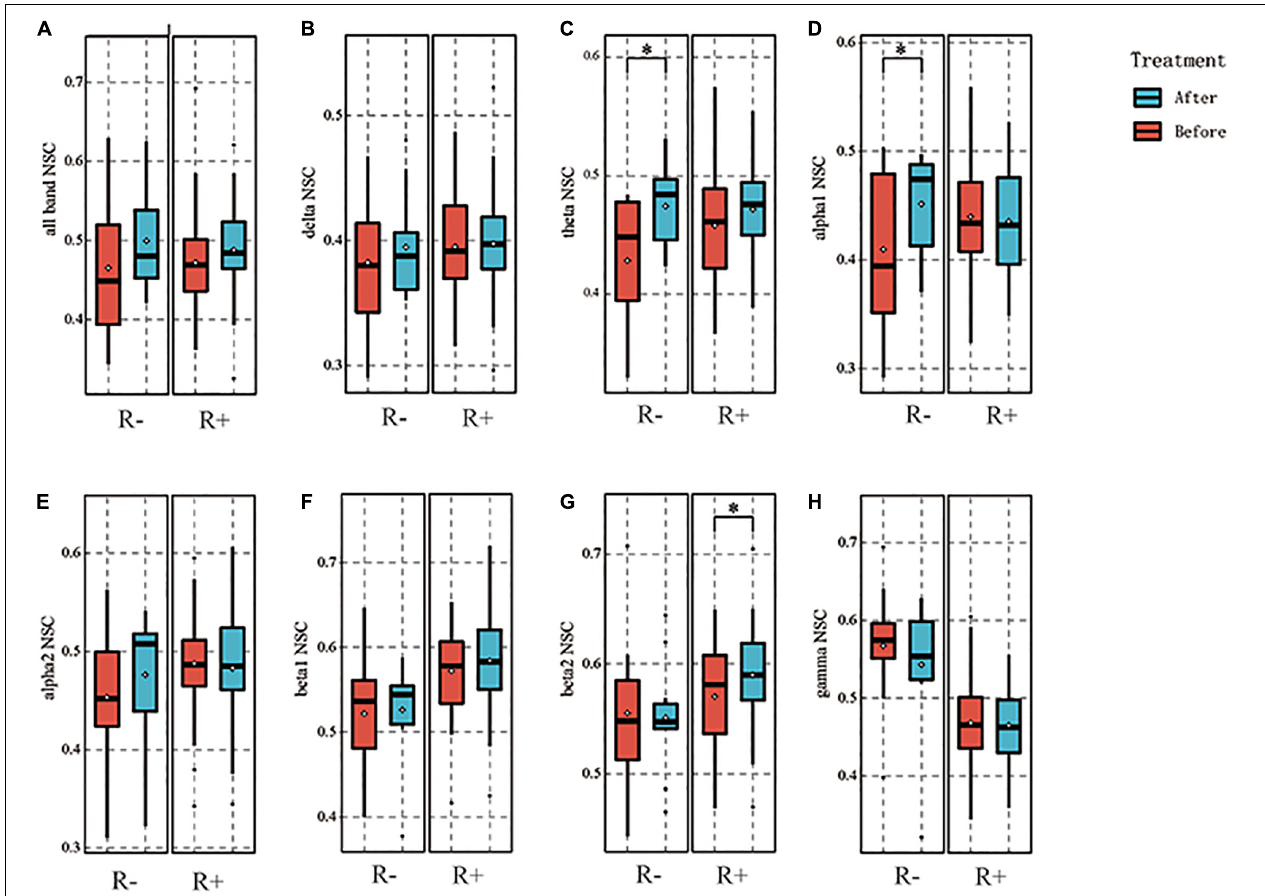
FIGURE 5 | Results of normalized spatial complexity (NSC) for each frequency band. For the R- and R + group, the NSC of the all frequency band was not significantly different between before and after stimulation, p = 0.206, 0.084 (A) . Delta band did not differ between before and after stimulation, p = 0.708, 0.448, respectively (B) . Theta band was not significantly different for the R + group, p = 0.071; the R- group was higher after stimulation than before stimulation, p = 0.024. (C) . In the alpha1 band, no significant difference was found in the R + group between before and after stimulation, p = 0.608, and the R- group increased after stimulation, p = 0.035 (D) . Alpha2 band also showed no significant difference between before and after stimulation for the two groups, p = 0.504, 0.127, respectively (E) . In the beta1 band, no significant difference was found between the two groups before and after stimulation, p = 0.370 and 0.756, respectively (F) . In the beta2 band, the R + group showed an increase compared to the pre-stimulation, p = 0.030, and the R- group showed no difference, p = 0.849 (G) . In the gamma band, no difference was observed between the two groups, p = 0.122 and 0.468, respectively (H) . * p <